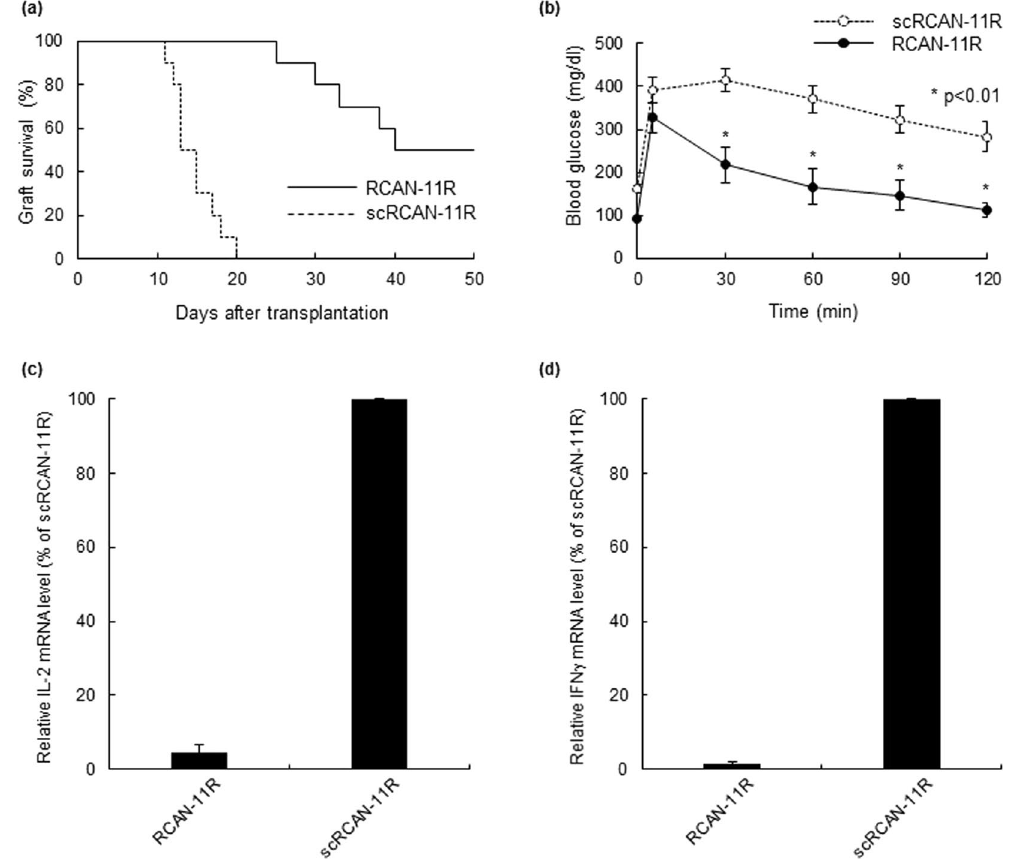
Figure 4. The effects of RCAN-11R on islet transplantation. ( a ) The differences in the duration of graft survival between the RCAN-11R group (n = 10) and the scRCAN-11R group (n = 10), as evaluated by a Kaplan-Meier log-rank test. ( b ) Intraperitoneal glucose tolerance testing (IPGTT). IPGTT was performed ten days after transplantation. Glucose (2.0 g/kg body weight) was intraperitoneally injected. ( c , d ) The inhibition of IL-2 ( c ) or IFN γ ( d ) transcription in vivo . Ten days after transplantation, islet allografts with lymphocyte (n = 3 each) were surgically obtained from kidneys and the cells were subjected to a quantitative RT-PCR. * p < 0.01 in comparison to scRCAN-11R at the same time. The values represent the mean ±